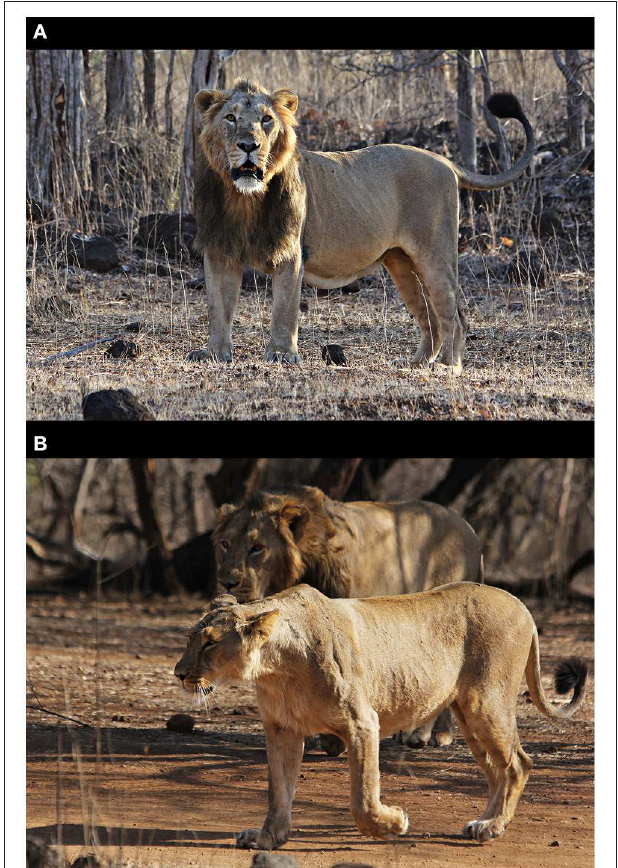
FIGURE 1 | Face and body profiles of Asiatic lions. (A) Adult male, note the sparser mane (than African lions) that does not cover the ear and the top of the head with a Mohawk look, and the prominent belly-fold; and (B) adult female, with a longer sloping snout and side face profile than African lionesses. Also, note the size difference between the male and the female (a consorting pair). Photographs taken by Stotra